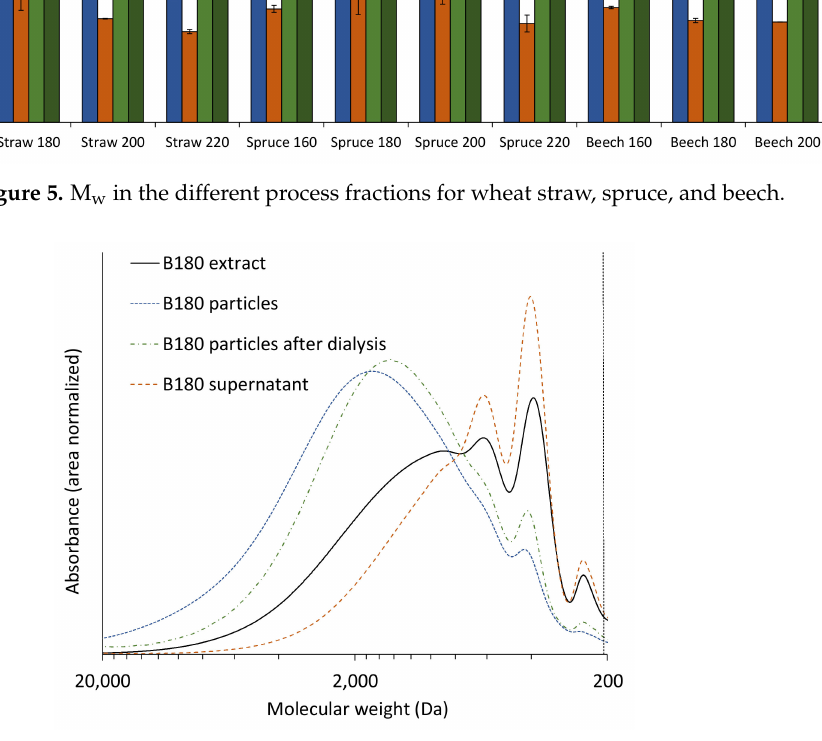
Figure 6. Molecular weight distributions of extract, particles, particles after dialysis, and supernatant from beech wood experiments at 180 ◦ C pretreatment